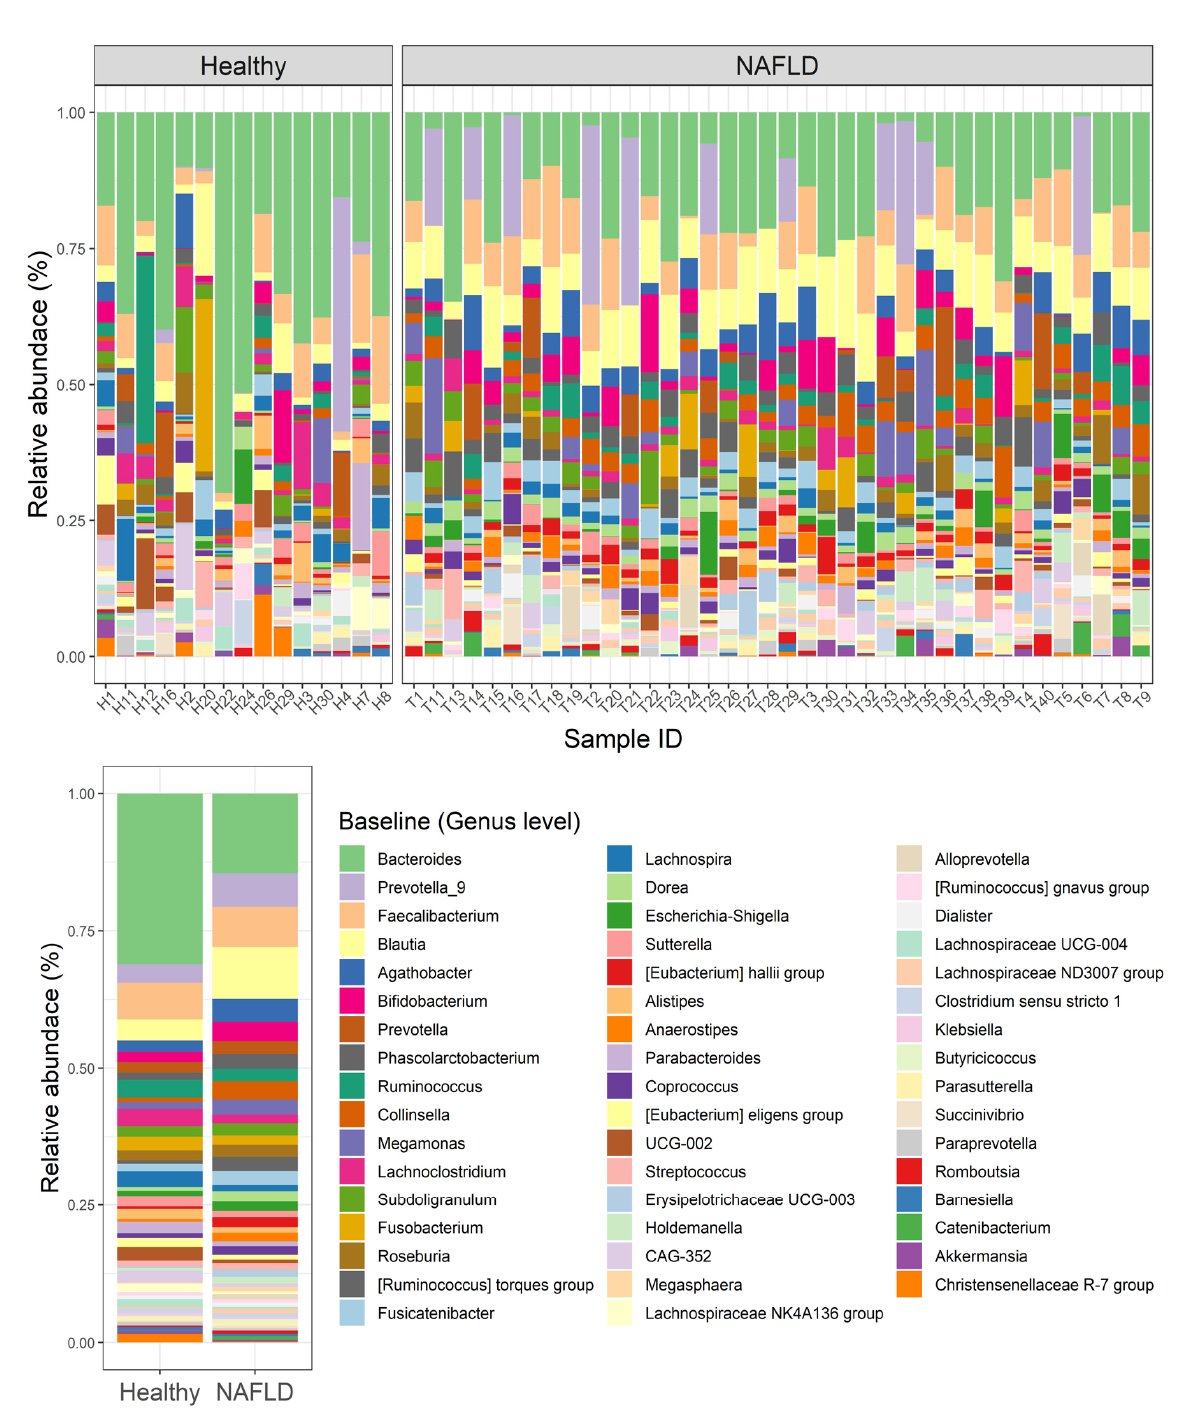
Figure 3. Top 50 relative abundance of bacterial genera in healthy controls and patients with NAFLD at week 0. NAFLD, Non-Alcoholic Fatty Liver Disease; UCG, uncultured genus-level group; CAG, Co-Abundance